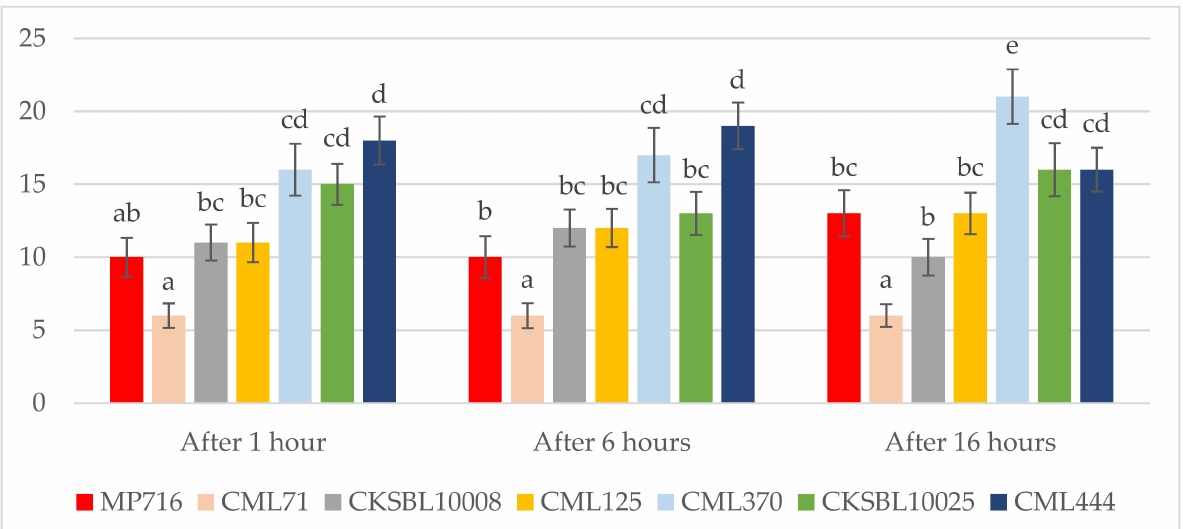
Figure 3. Mean percentage ( ± SE) of Spodoptera frugiperda neonates found on leaf portions of each inbred line under multiple choice conditions after 1, 6 and 16 h of bioassay among inbred lines (n = 71–75) in a Petri dish. Means within each experimental time followed by different letters are significantly different at 5% probability level according to Dunn’s